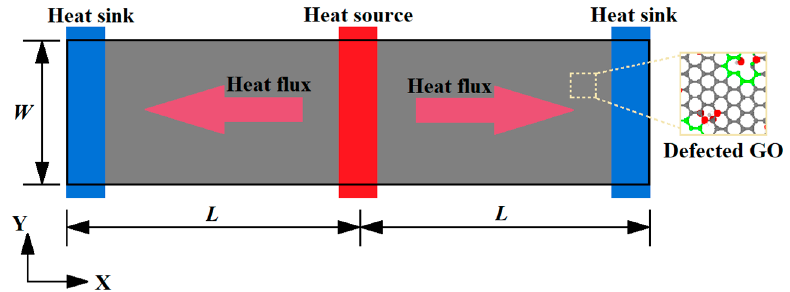
Figure 2. Schematic model for thermal conductance of GO using periodic boundary conditions.